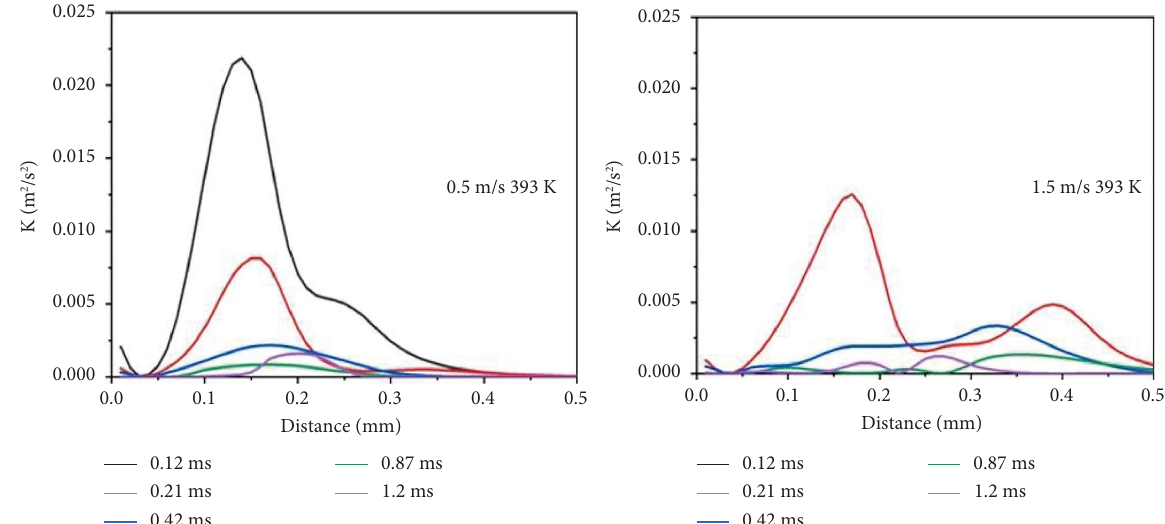
Figure 6: Turbulent kinetic energy variation in perpendicular to collision direction.